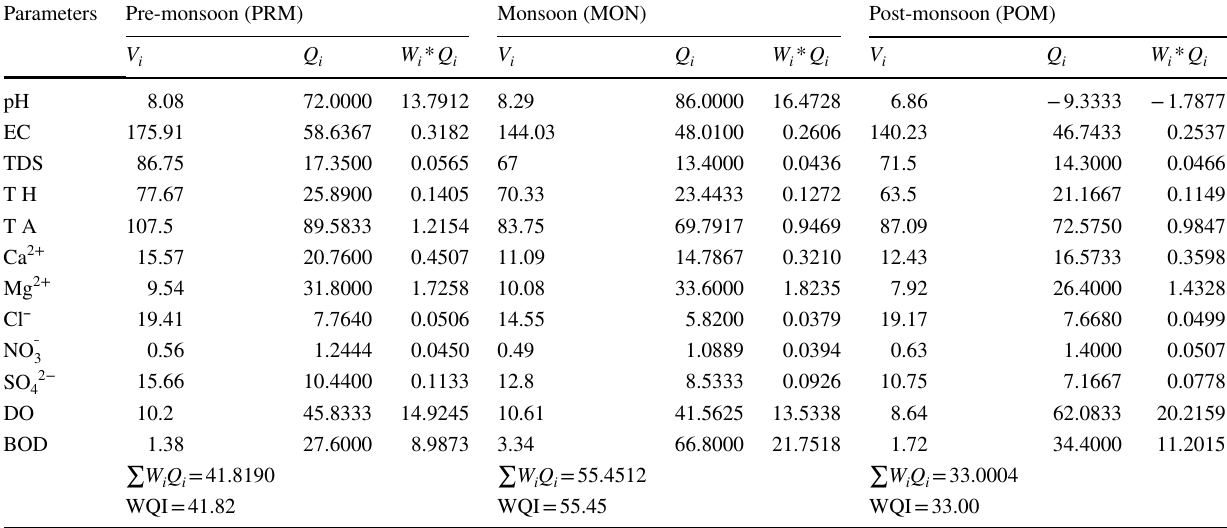
Table 8 Calculation of WQI at station 4 (S 4) Parameters